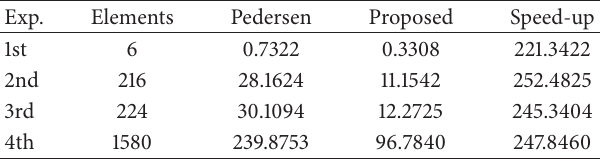
Figure 10: The liver mesh is constrained at the blue nodes and pulled from the green node ((a) initial nodes; (b) initial shaded mesh and nodes). Table 9: Computation times (in seconds) of stiffness matrices (Pedersen: Pedersen’s nonlinear FEM; Proposed: proposed nonlin- ear FEM; and Speed-up: relative performance comparison of the stiffness matrix calculation of the proposed nonlinear FEM method with Pedersen’s nonlinear FEM method using single thread).